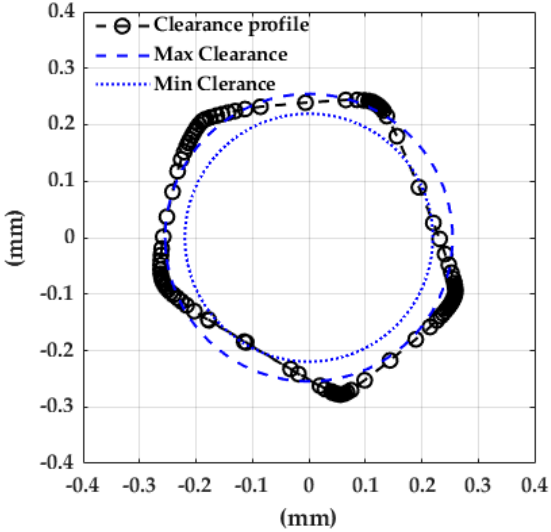
Figure 11. Flooded Rocker Pivot bearing clearance profile from the bump test.